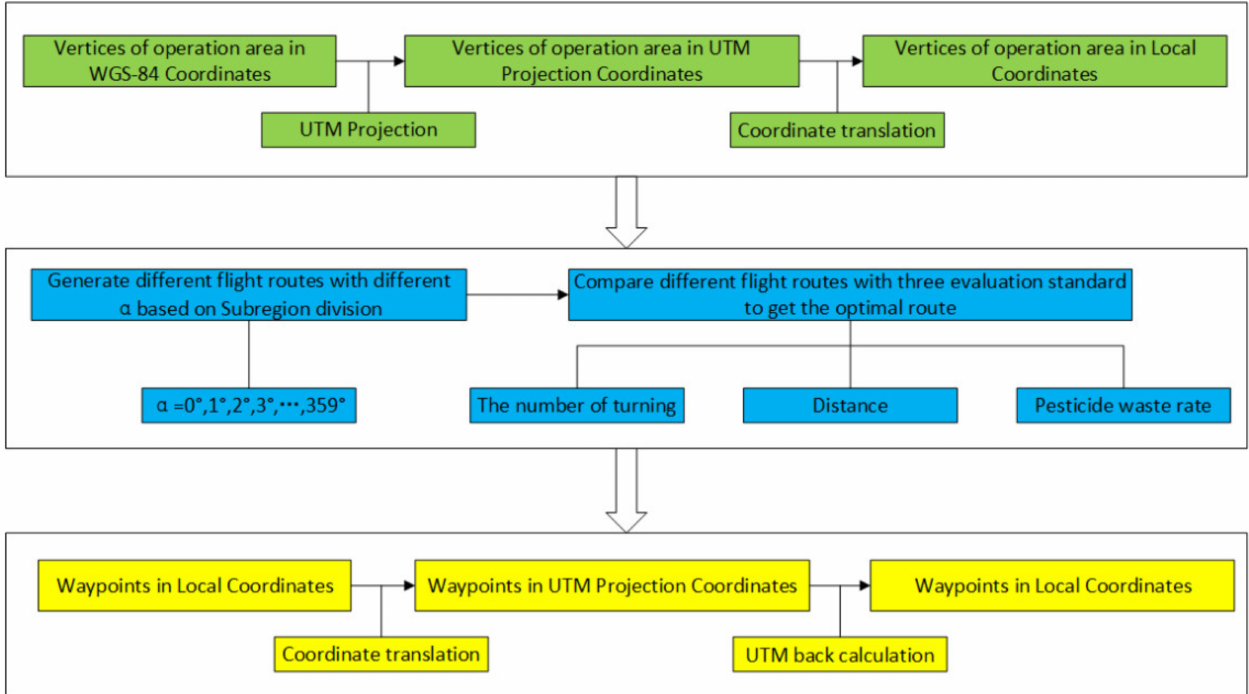
Figure 1. Overall flow chart of the route-planning method proposed in this